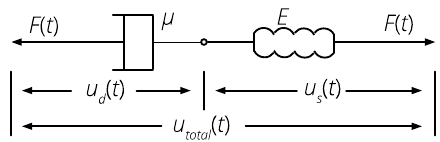
Fig. 2. The mechanical analog of the Maxwell model of